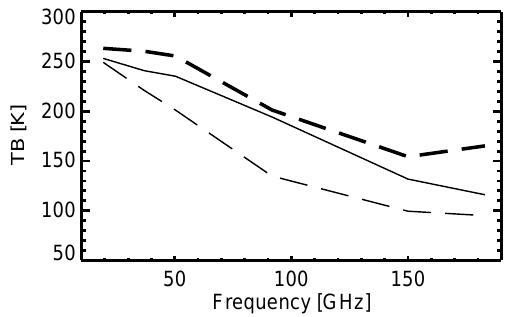
Figure 10. Influence of the size distribution on the Liu (2008) sec- tor snowflake results, for a single case in the centre of Hurricane Irene. The thin solid line shows results with the Field et al. (2007) size distribution; the thin dashed line shows the Marshall–Palmer results. The thick dashed line shows the